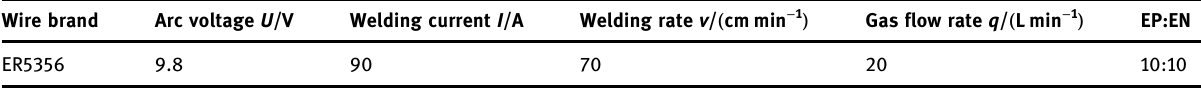
Table 1: Process parameters for AC CMT welding